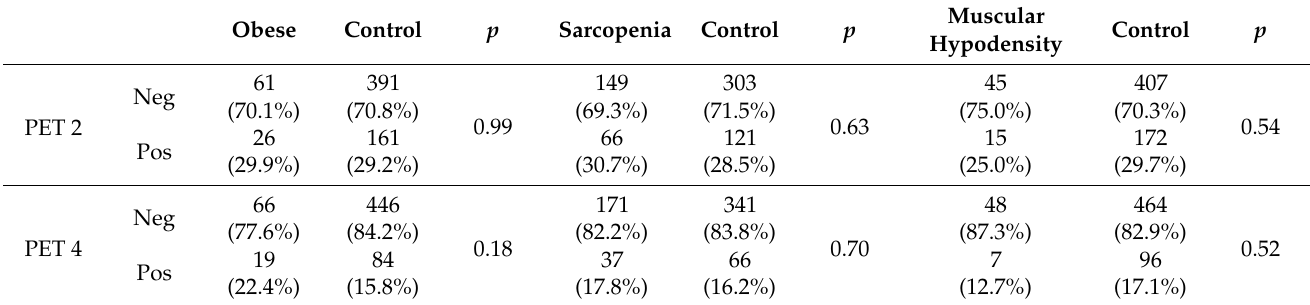
Table 3. PET2 and PET4 results according to obesity, sarcopenia, and muscular hypodensity.